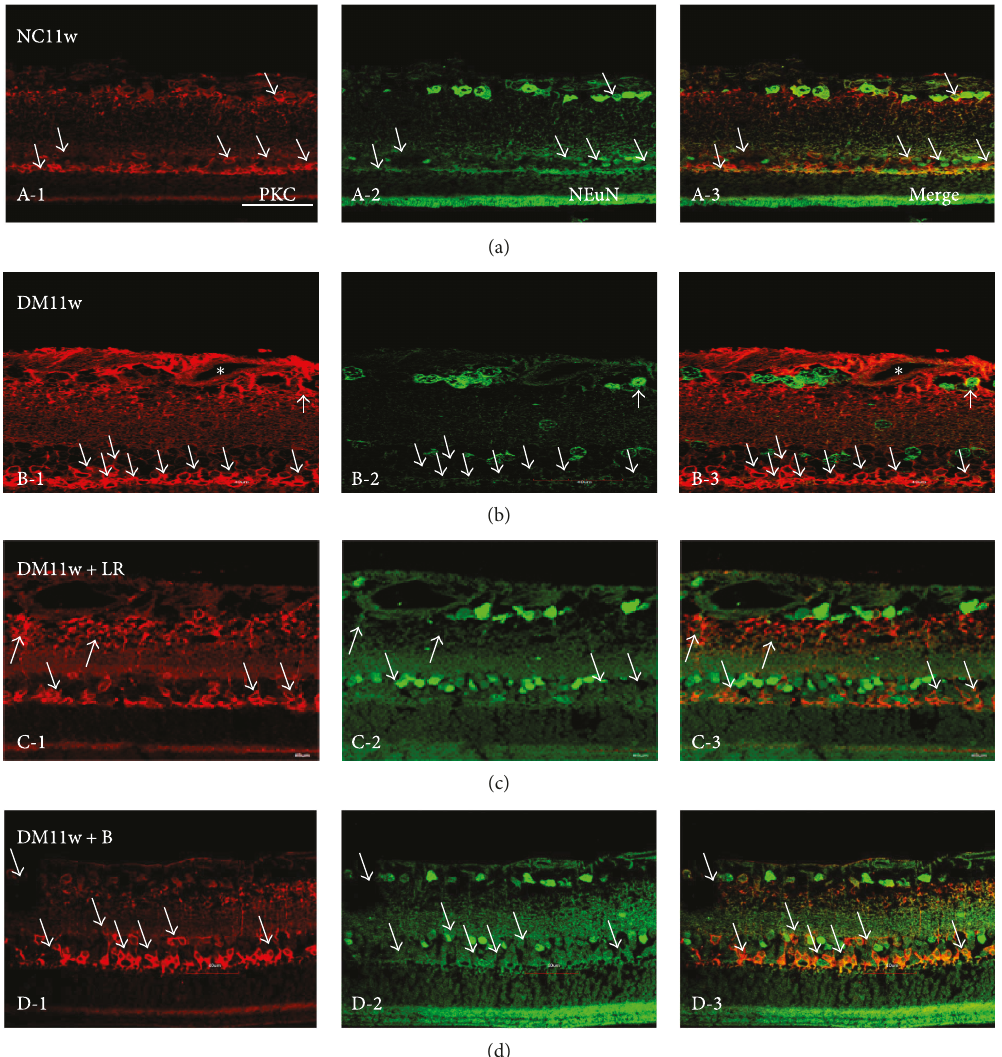
Figure 10: Representative photomicrographs of PKC (red) and NeuN (green) double staining of the retina in the NC11w, DM11w, DM11w +LR, and DM11w+B groups. PKC immunoreactivity was localized in NeuN-labeled neurons (single arrow) and blood vessels (asterisk). Bar=50 μ